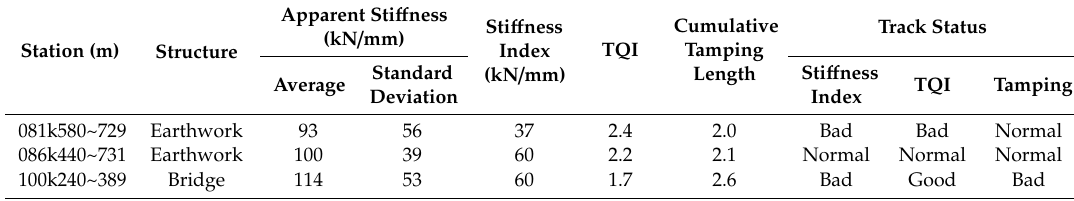
Table 8. Verification results of the track status evaluation